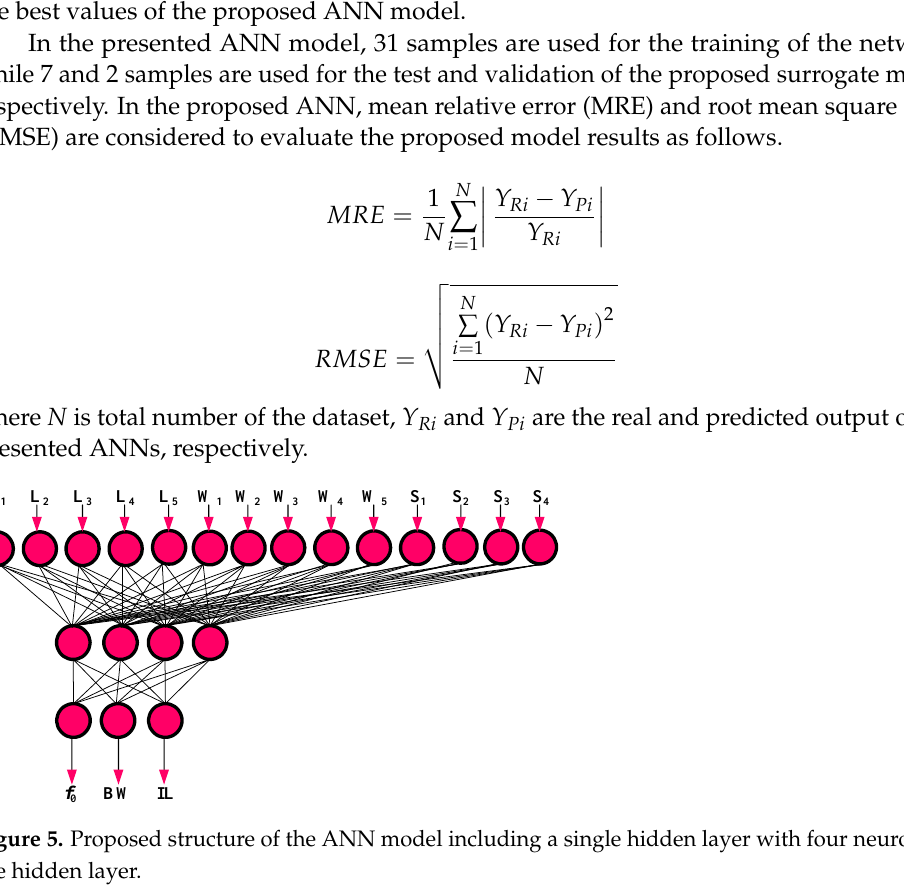
(2) where N is total number of the dataset, Y Ri and Y Pi are the real and predicted output of the presented ANNs, respectively. Results of the Proposed ANN Model As mentioned, the presented model with structure of a single hidden layer and four neurons in the hidden layer is selected as the most precise model. The real and predicted comparison values of f 0 (GHz), BW (MHz), and IL (dB) parameters for train and test data are shown in Figure 6. As can be seen, the predicted data are obtained accurately.